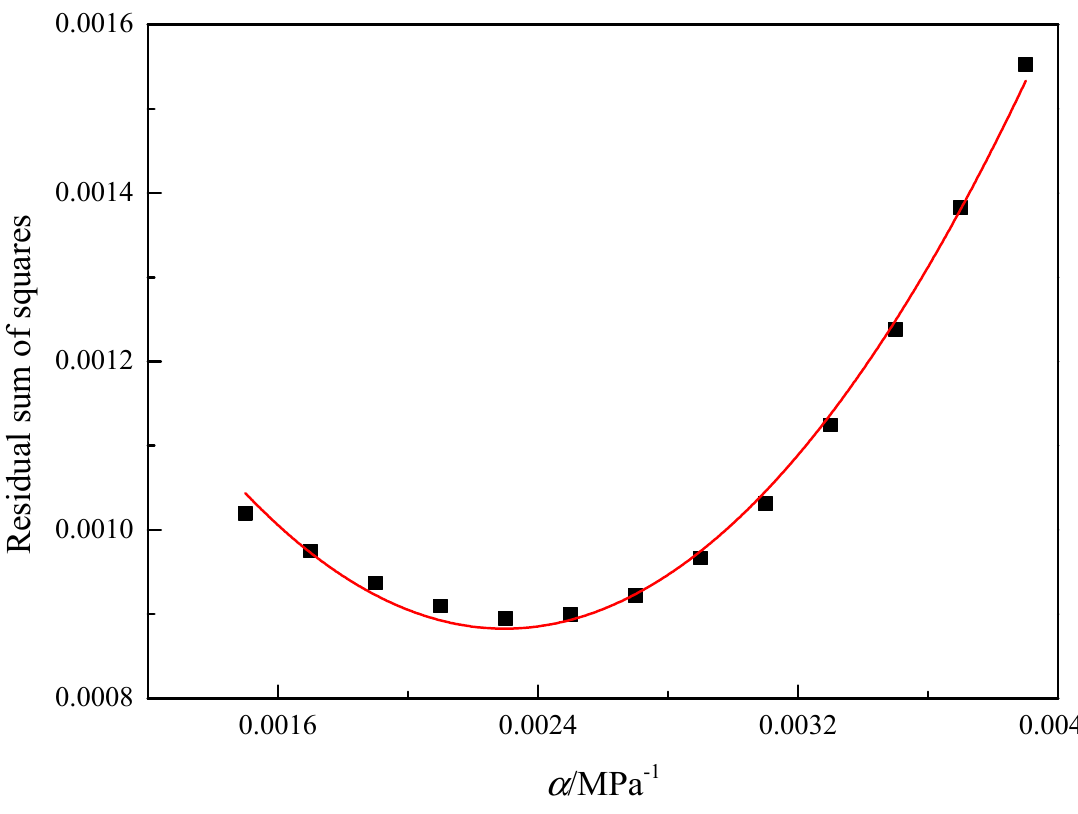
Figure 6. The relationship between the residual sum of squares and α value of GH3230 superalloy double-sheet at the true strain of 0.3.